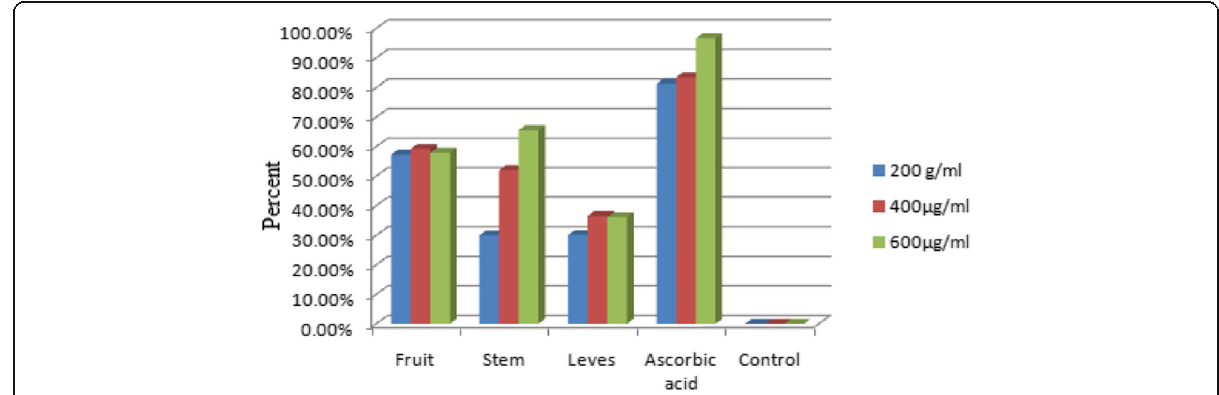
Fig. 2 %Antioxidant activity of chloroform extracts by DPPH method [21]